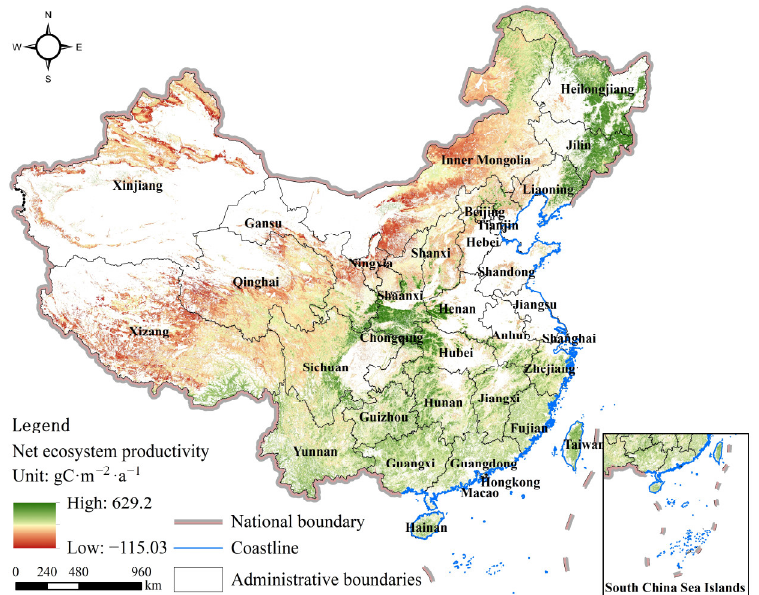
Figure 3. Spatial distribution of multi-year mean NEP in CES.